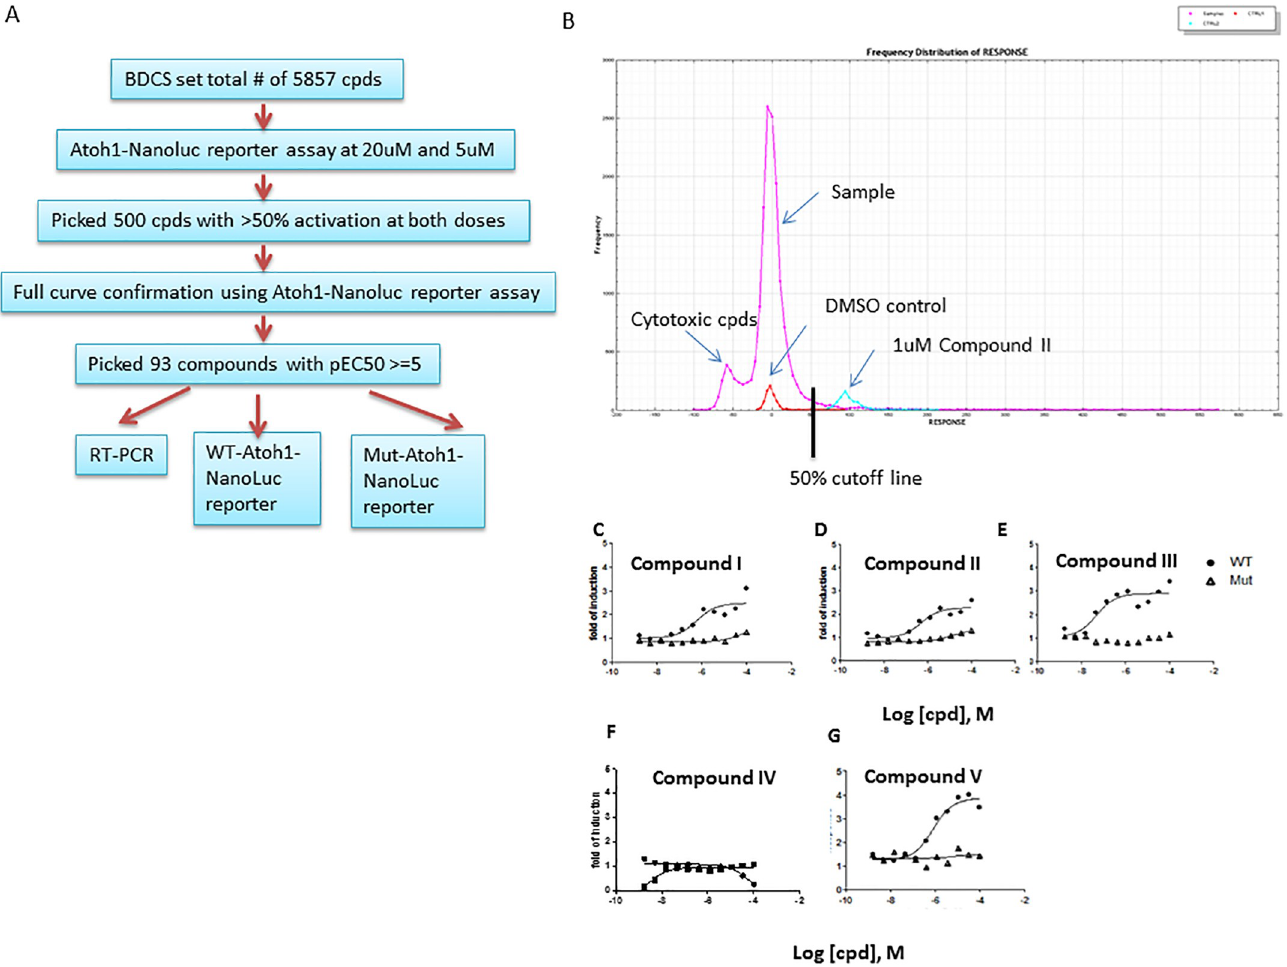
Fig 2. Focused library screen for inducers of Atoh1 using Atoh1 -NanoLuc reporter assay. A. The screening and hit triage work flow. B. The distribution frequency of the compound activity in the primary screen using 5uM and 20uM as final compound concentrations. The statistical cutoff in the 20uM screen was 55% based on 3X robust standard deviation of the DMSO samples. To be inclusive, the 50% activation was used as cutoff at either dose for selecting compounds for confirmation in full dose analysis in reporter assays (C, D, E, F, G). The data from WT and Mut reporter assays are overlaid and expressed as fold of induction by sample vs. DMSO